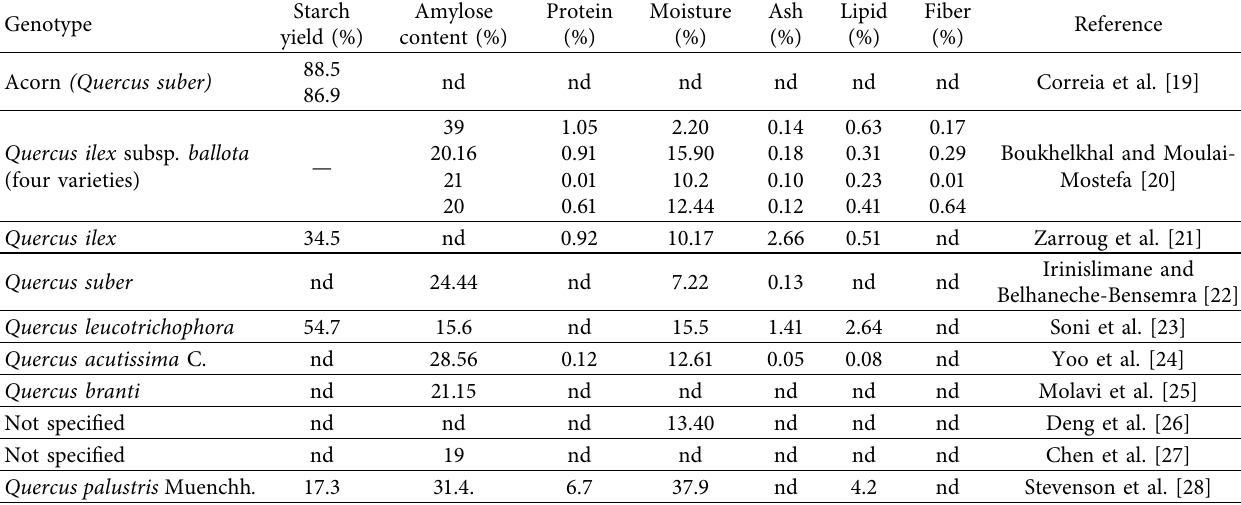
Table 1: Yield and chemical composition of acorn